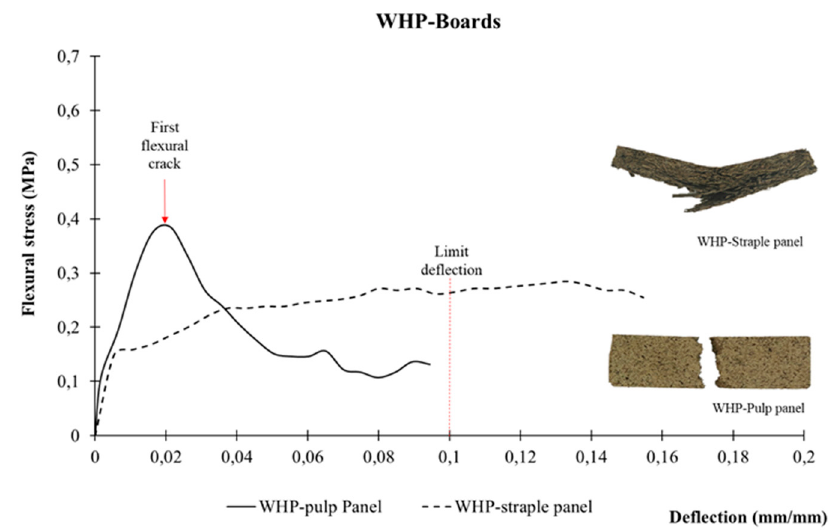
Figure 8. Flexural test: Stress–strain (mm/mm) curve of WH boards.